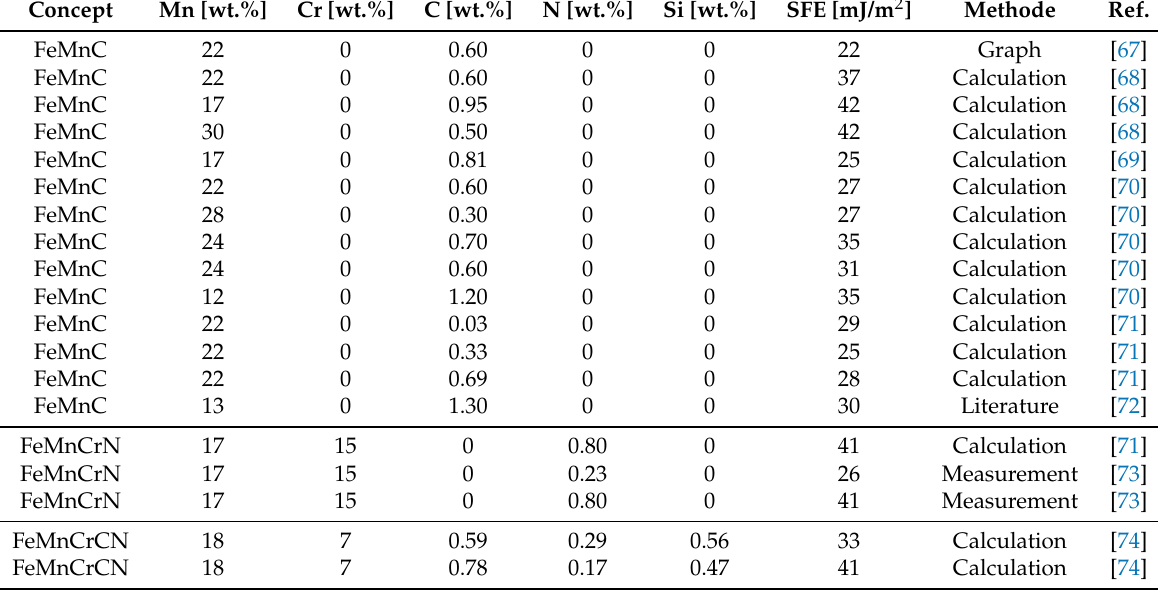
Table A1. Austenitic steels, their chemical composition and respective SFE, data belong to Figure 6.